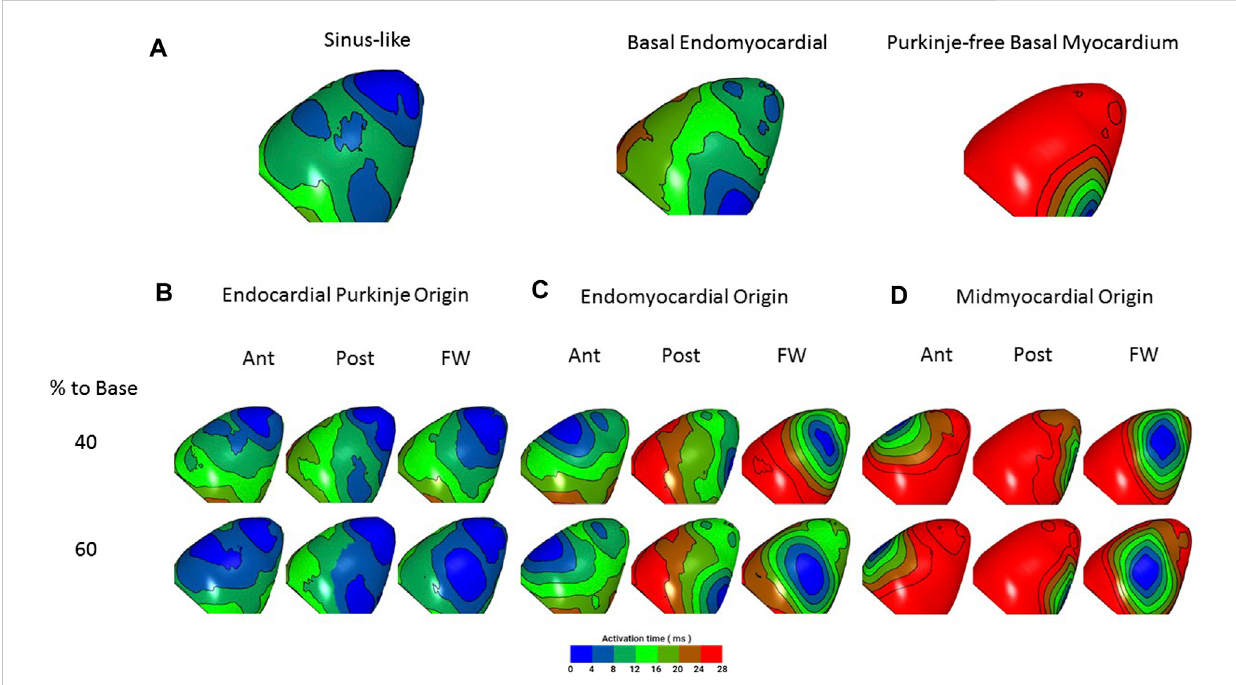
FIGURE 6 In silico simulation of epicardial activation in response to ectopic foci. Hearts are orientated with apex to the top to match experimental images. Epicardial activation is colour-coded as in the optical studies (Figures 4, 5). (A) Left, closest match to sinus stimulation (deep foci, PF origin 40% to base). Centre, match to basal endomyocardial stimulation (super fi cial foci, myocardial origin, 80% to base). Right, basal myocardial stimulation from a ‘ PF-free ’ region (deep foci, myocardial origin, 80% to base). There is close similarity between the characteristics of the activation patterns predicted by sinus and endomyocardial stimulation andthose optically recorded (seeFigure 5). Sinusstimulation leads to broaderinitial breakthroughand afaster spreadof activation. Note that endomyocardial stimulation that does not include PF propagation results in activation slower than that seen in Figure 4B. (B – D) Epicardial activation in response to ectopic foci (arising, for example from mechanical stimulation) in the LV anterior (Ant), posterior (Post) and free wall (Free)at40%and60%distancetotheLVbase. (B) fociwithanendocardialPForigin, (C) Fociwithanendomyocardialorigin, (D) Fociwithamidmyocardial origin. Activation spread is fastest from PF origins then from the endomyocardium and slowest from the midmyocardium. When compared with ectopic activations presented in Figures 5A,B, closest matches are with PF and endomyocardial origins (consistent with Lugol ablation of these ectopics). Crucially, the model predicts that ectopic depolarisation arising in the endomyocardium will migrate to and propagate through PFs, resulting in a faster